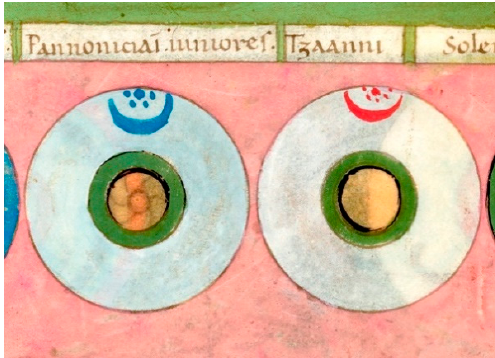
Figure 6. Notitia Dignitatum VIII, 16–17, Oxford, Bodleian Library, Canon Misc. 378, f. 94v, Basel, 1436. © Used with permission of the Bodleian Libraries, University of Oxford.